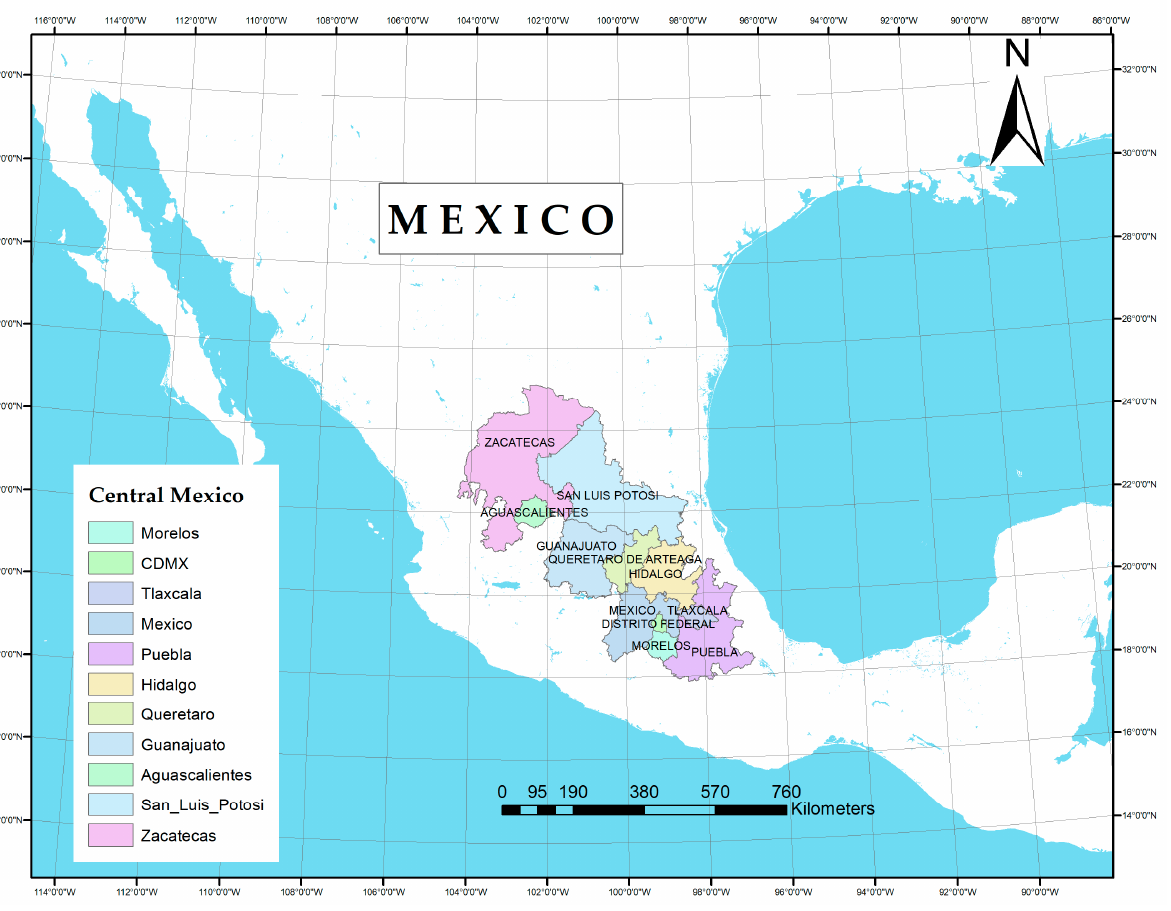
Figure 5. Central Mexican states.